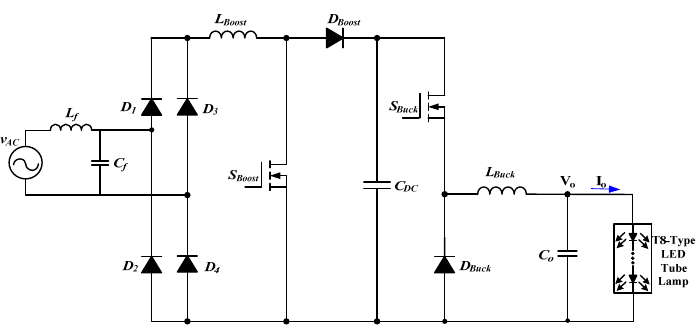
Figure 1. The commercial two ‐ stage driver for supplying a T8 ‐ Type LED (light ‐ emitting diode) tube lamp.